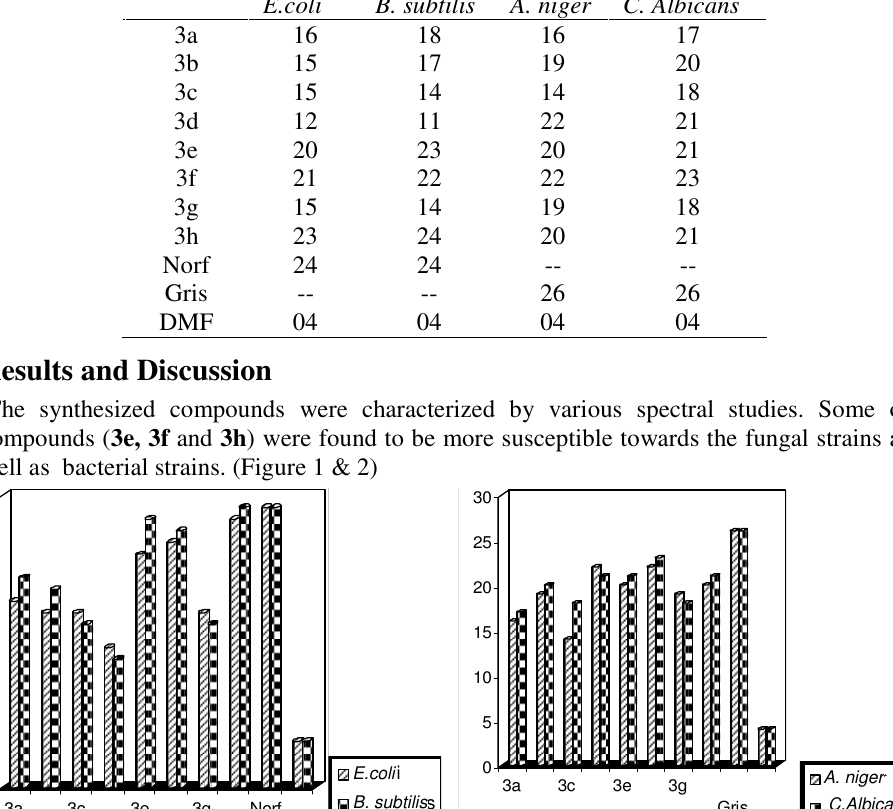
B. Figure 2. Antifungal activity of synthesized compounds.